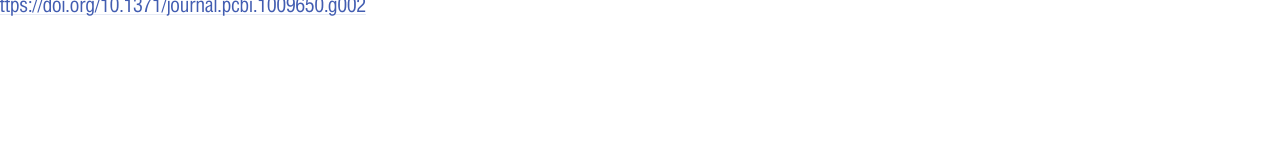
PLOS Computational Biology | https://doi.org/10.1371/journal.pcbi.1009650 December 13,